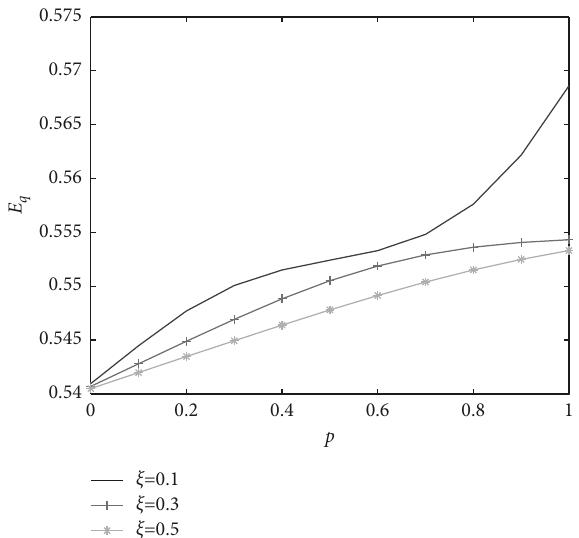
Figure 3: Effect of p on mean number of order size E impatient rate ξ .